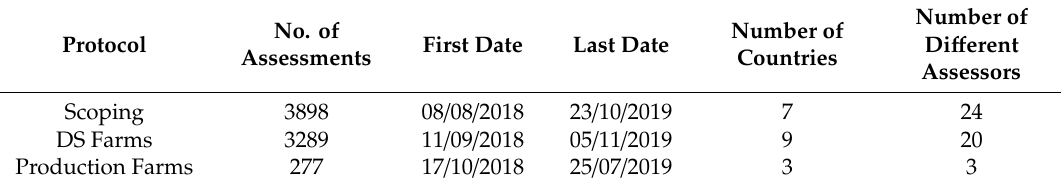
Table 4. Summary of the welfare assessment data collected during field-trialling using each of the three protocols.